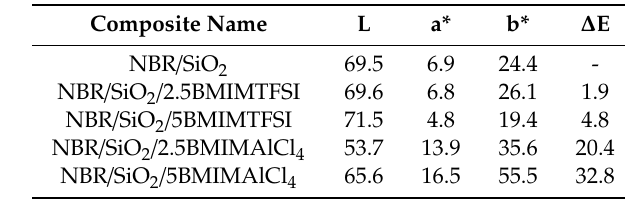
Table 2. Changes in the color parameters of the NBR composite after the addition of ionic liquids at di ff erent